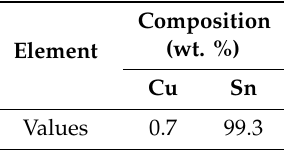
Table 1. Selected composition of the Sn-Cu alloy.